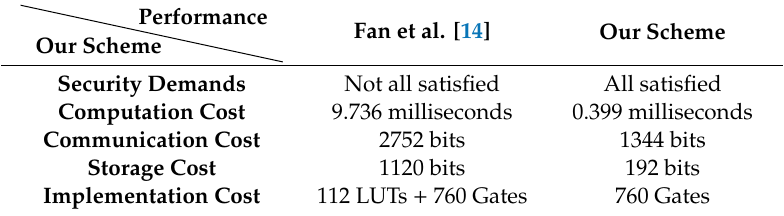
Table 9. Performance comparison between our proposed scheme and Fan et al.’s